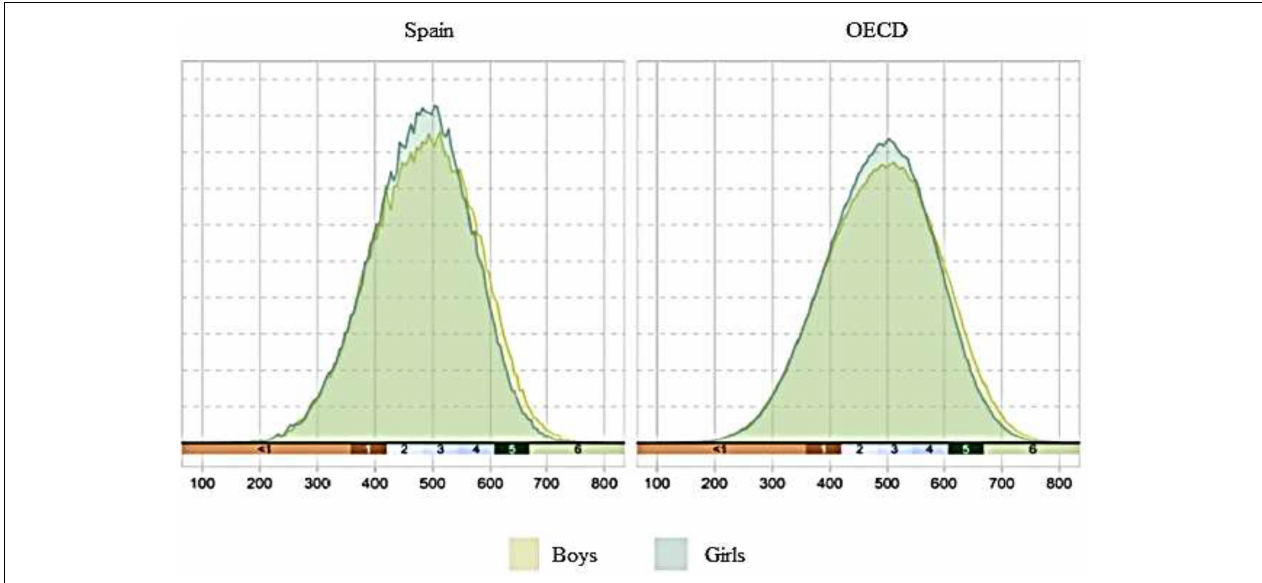
FIGURE 1 | Performance levels and gender in PISA 2018 for Spain and the OECD. Source: Ministerio de Educación y Formación Profesional (2019), p. 89.